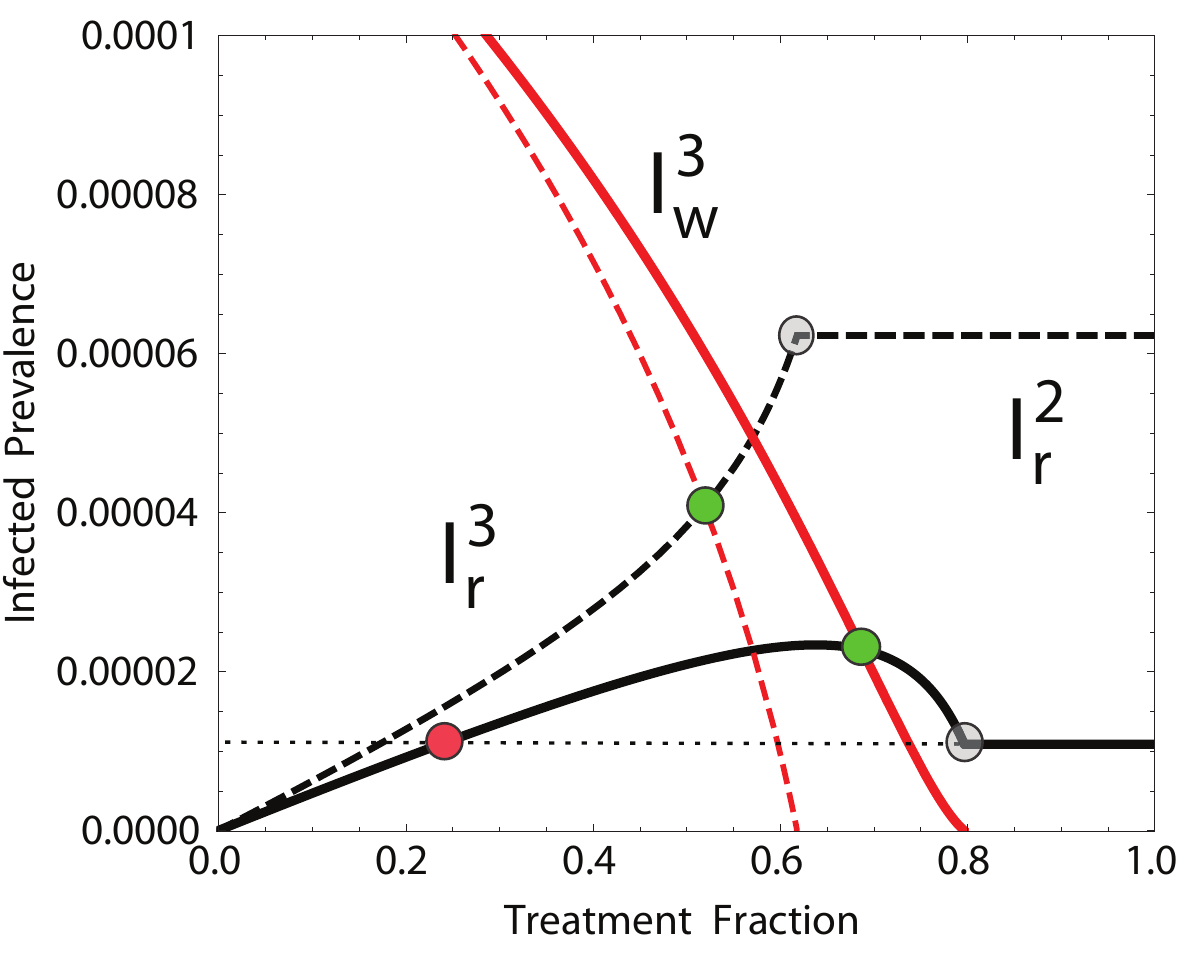
Figure 3. The two possible monotonicity behaviors of I 3 ( r ) . In black, I 3 ( r ) is concave for R r ( w ) v (1 { r (cid:3) c ) { 1 (solid lines) ( w ~ 0 : 42 ), and r r 0 monotonically increasing for R r ( w ) § (1 { r (cid:3) c ) { 1 (dashed lines) ( w ~ 0 : 55 ). Red lines are the corresponding I 3 ( r ) curves. The x-values of the green and w 0 ) increases, the red dot moves rightward, gray dots represent r e and r (cid:3) , respectively, while the x-value of the red dot represents r r . As w (or R r 0 surpassing the green dot ( r r ~ r e ), and eventually surpassing the gray dot as well ( r r ~ r (cid:3) ). At this point, the system displays a transcritical bifurcation between the CFP and the RFP. Other parameters: c r ~ c u ~ 0 : 2, t ~ 0, b u ~ 0 : 5, m ~ 0 : 34, c ~ 0 : 2 . A large value of c was used to magnify the difference between the two cases.